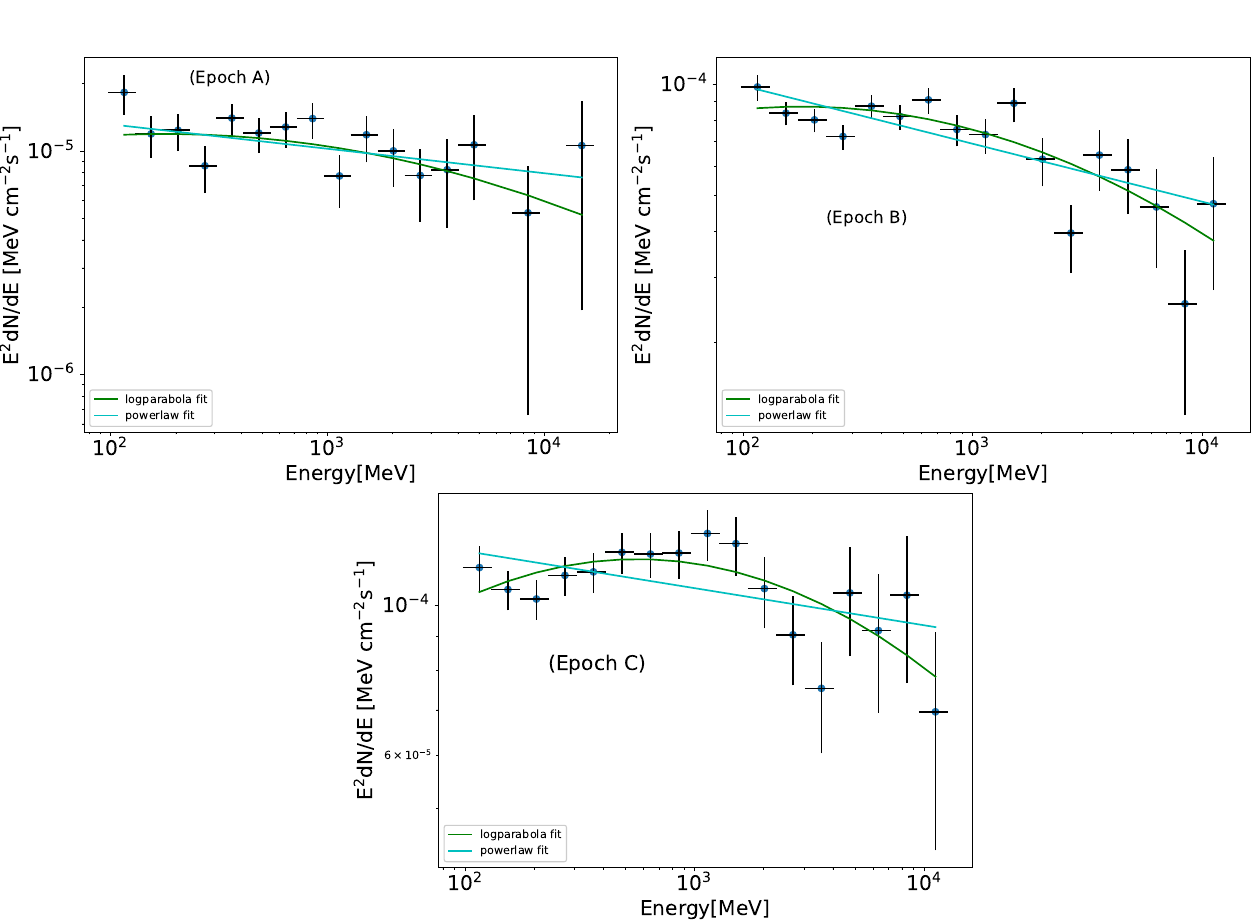
Figure 2. γ -ray spectrum for the epochs ( A – C ). The name of the epoch is mentioned in each